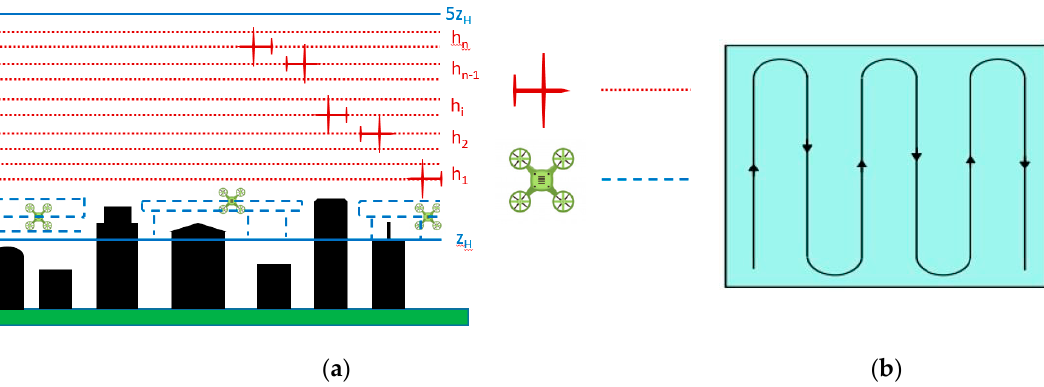
Figure 1. ( a ) Measurement profiles flown simultaneously by a combination of instrumented multirotor (dashed) unmanned aircraft around the inhomogeneous urban canopy and fixed-wing (dotted) unmanned aircraft assigned to h n discrete layers for horizontal averaging; ( b ) plan view of the lawn mower flight pattern flown at one altitude across a given local climate zone (LCZ) for horizontal averaging. Neither Figure 1a or Figure 1b is drawn to scale.